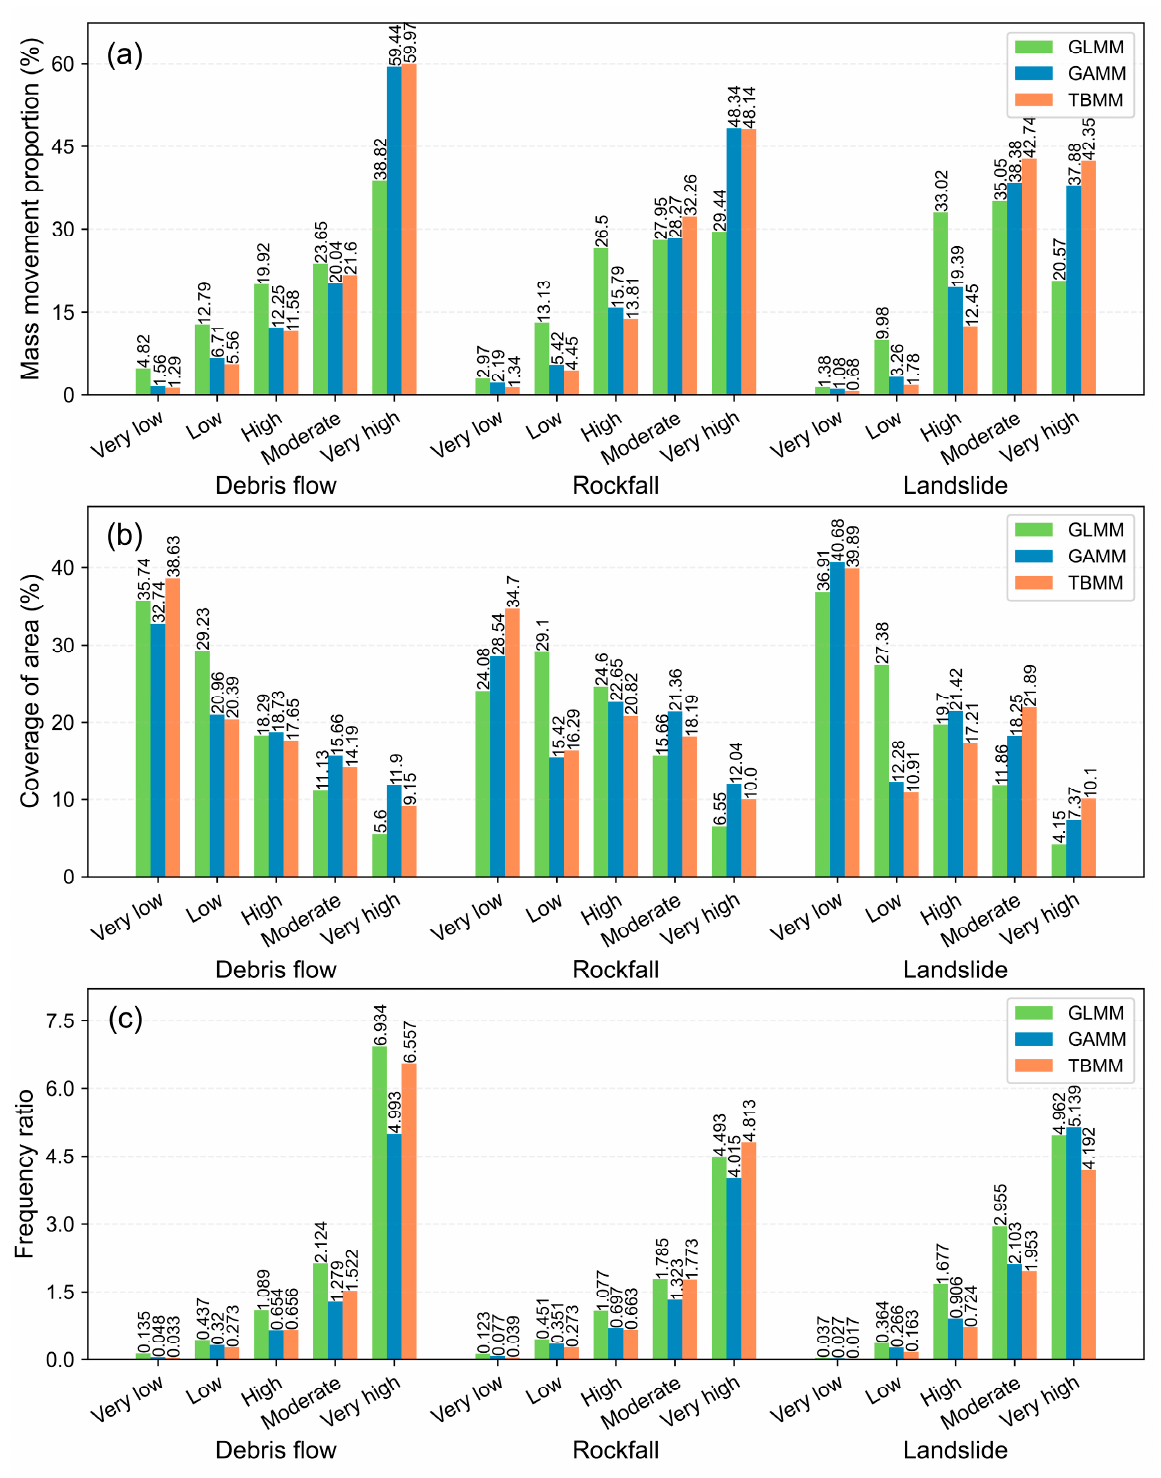
Figure 11. Statistics on the susceptibility maps of three type of mass movements. ( a ) distribution of mass movements in each susceptibility class; ( b ) distribution of susceptibility classes; ( c ) frequency ratio of mass movements in each susceptibility class.